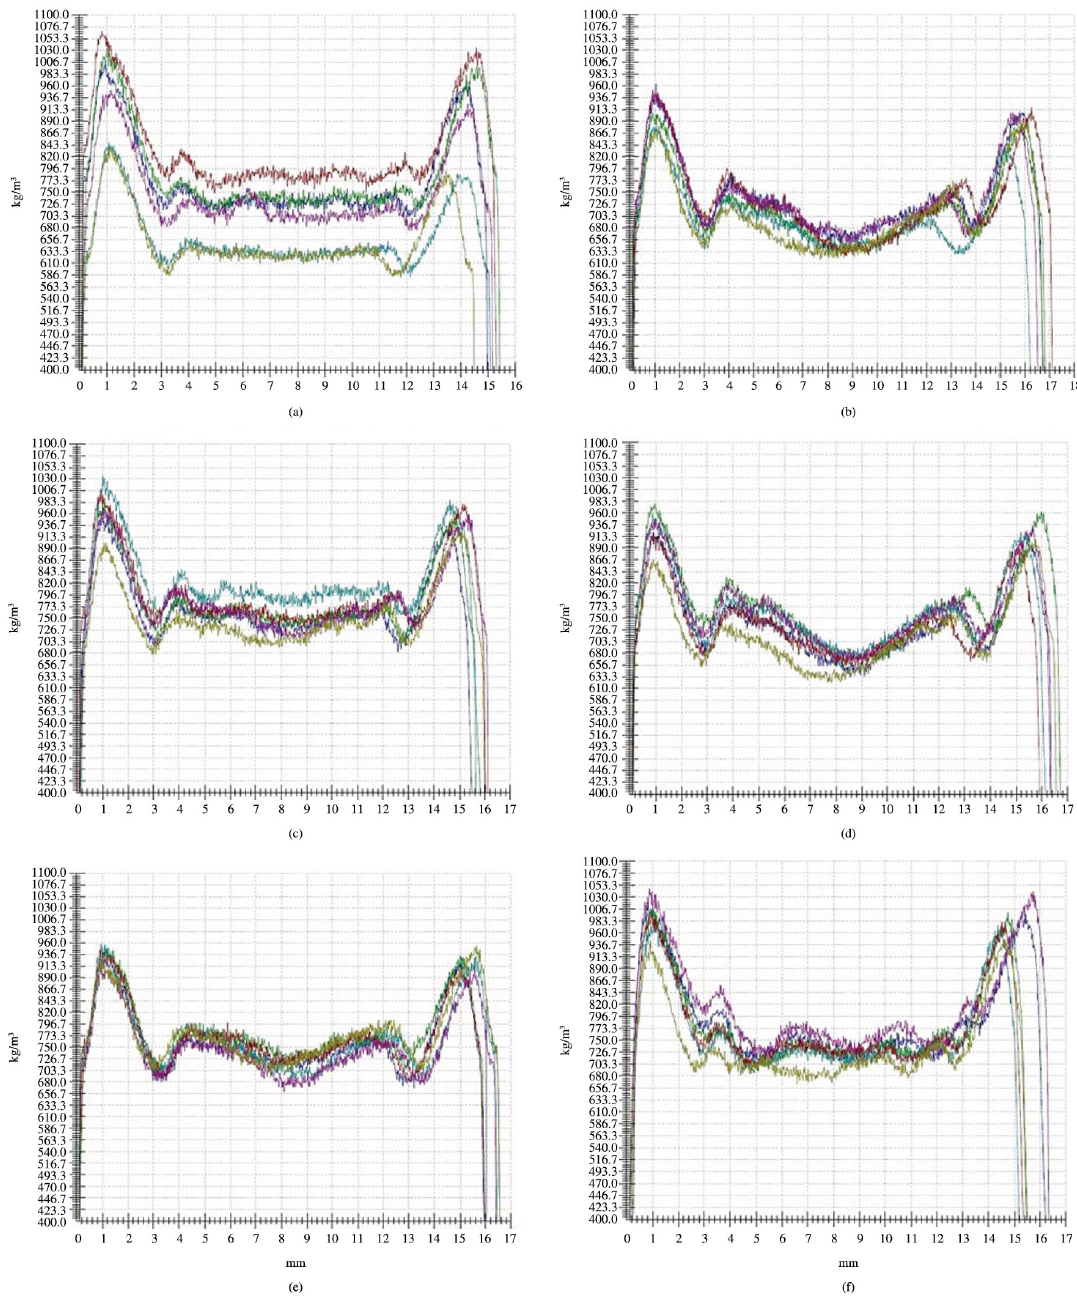
Figure 4. Density profiles, Step B, with 13% resin. (A) 100% eucalyptus, (B) 5% bagasse and 95% eucalyptus (C) 10% bagasse and 90% eucalyptus, (D) 15% bagasse and 85% eucalyptus; (E) 20% bagasse and 80% eucalyptus, (F) 25% bagasse and 75%